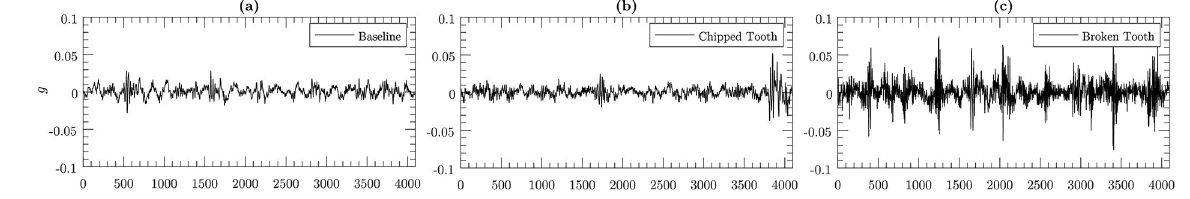
Fig 8. Sample signal representing (a) baseline condition, (b) chipped tooth condition, and (c) broken tooth condition. The sample signals shown here are taken from experimental condition of high load and 50 rps (3000 rpm) rotational